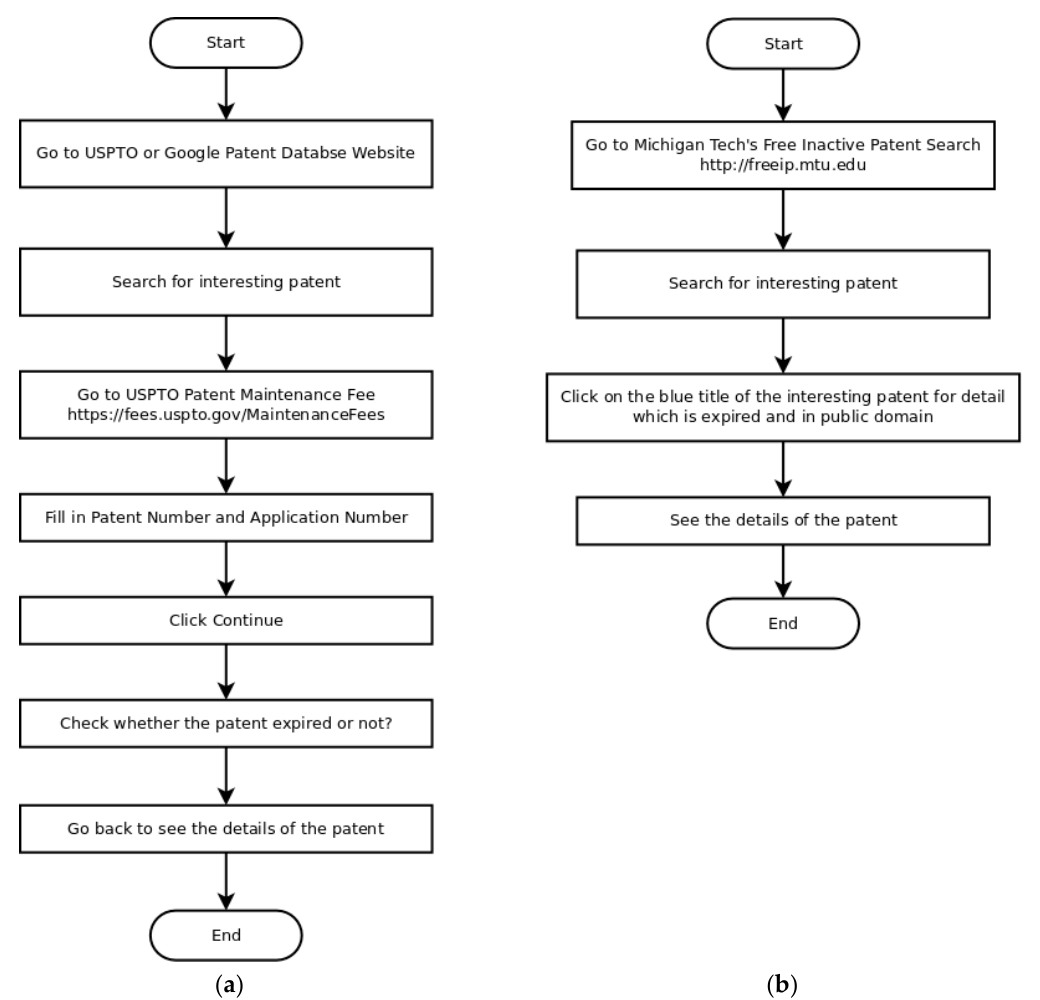
Figure 4. Search approaches for the USPTO Public PAIR (Patent Application Information Retrieval) vs. Michigan Tech’s Free Inactive Patent Search: ( a ) Public PAIR approach; ( b ) Free Inactive Patent Search approach.